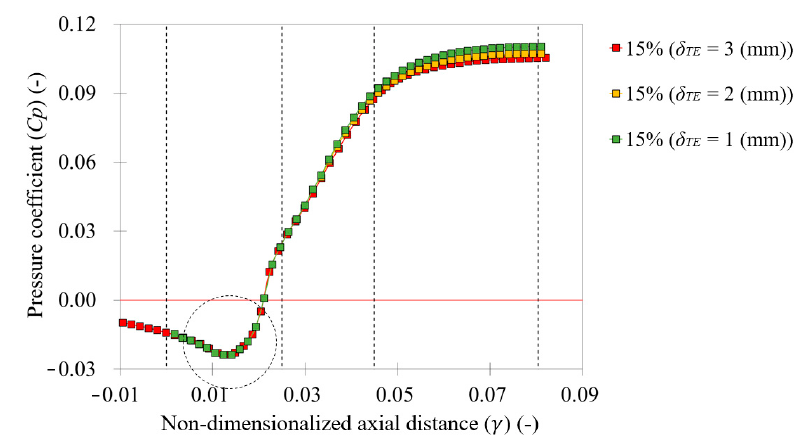
Figure 23. Pressure rise curves with different trailing edge thickness treatments ( 𝛷/𝛷 (cid:3031)(cid:3032)(cid:3046) = 1.0 ).